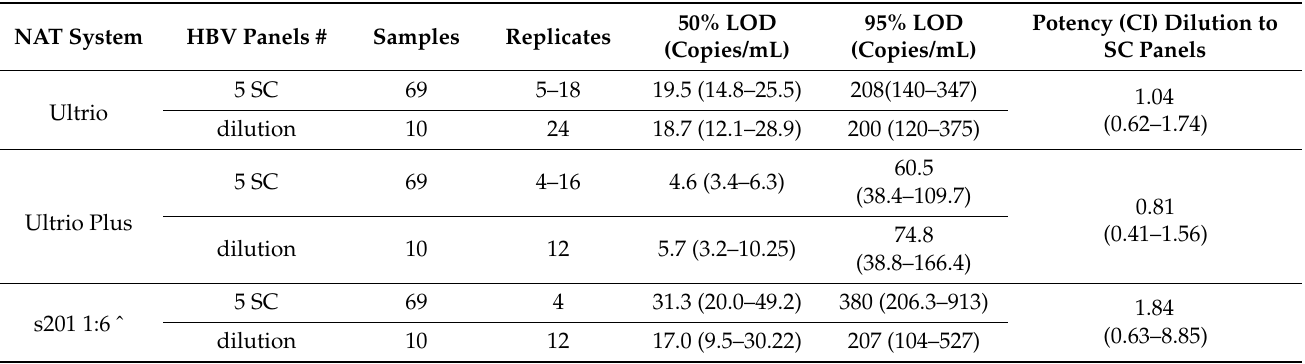
Table 2. Comparison of NAT conversion points with three test systems on five seroconversion (SC) panels with LODs on HBV genotype A standard dilution panel using parallel line probit analysis.